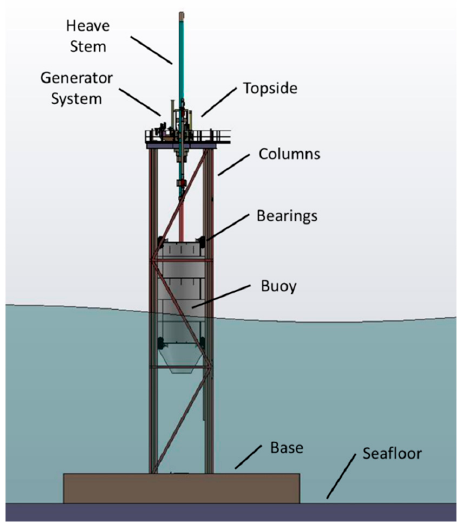
Figure 20. Components of the COPPE nearshore WEC.